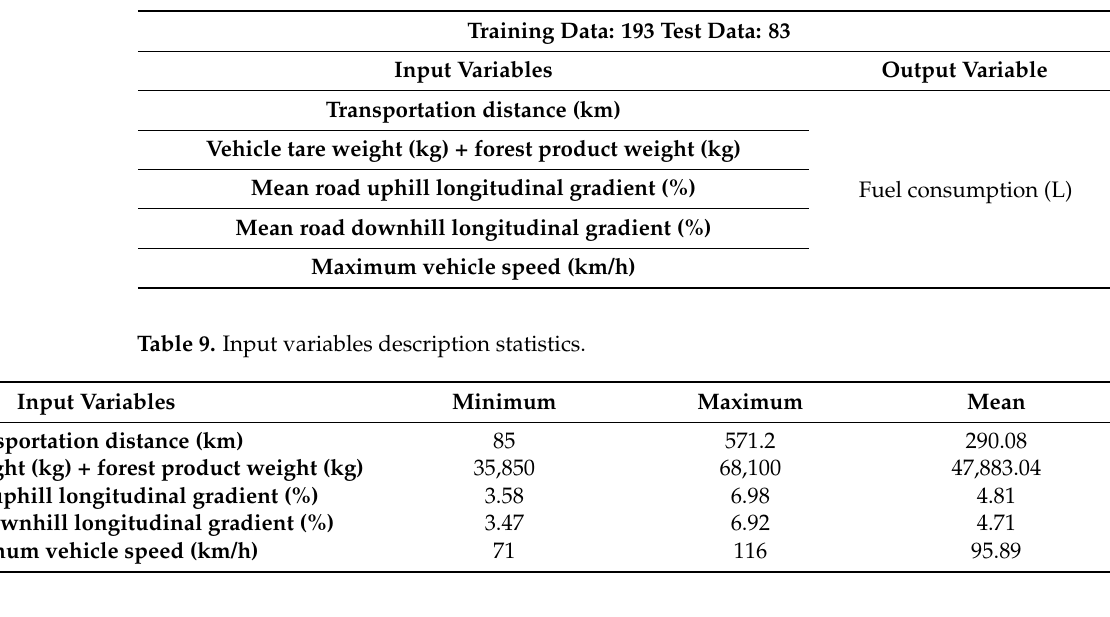
Table 8. Input and output variables for fuel consumption model.